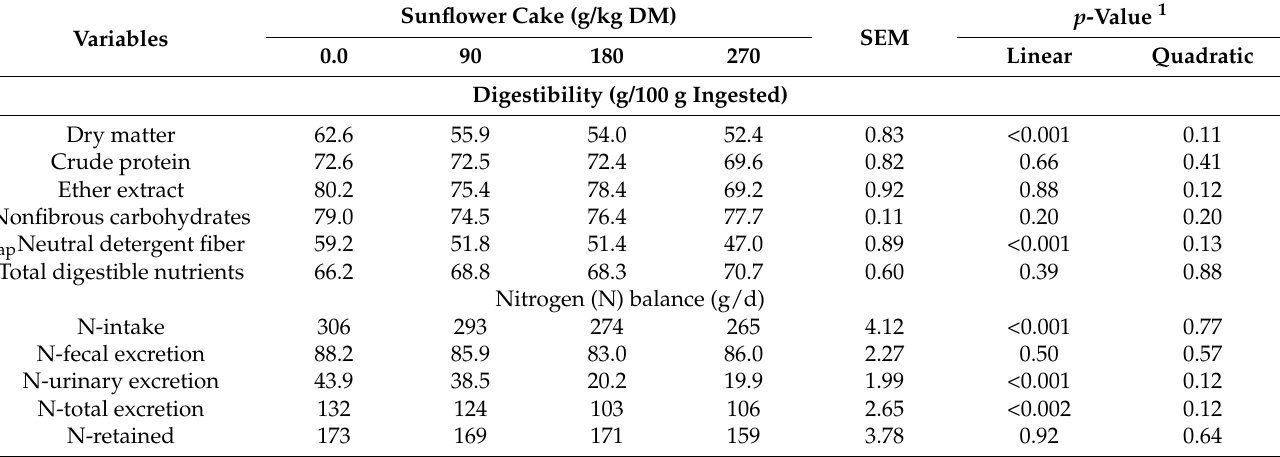
Table 4. Digestibility, microbial production efficiency, and blood serum metabolites in young bulls fed diets containing sunflower